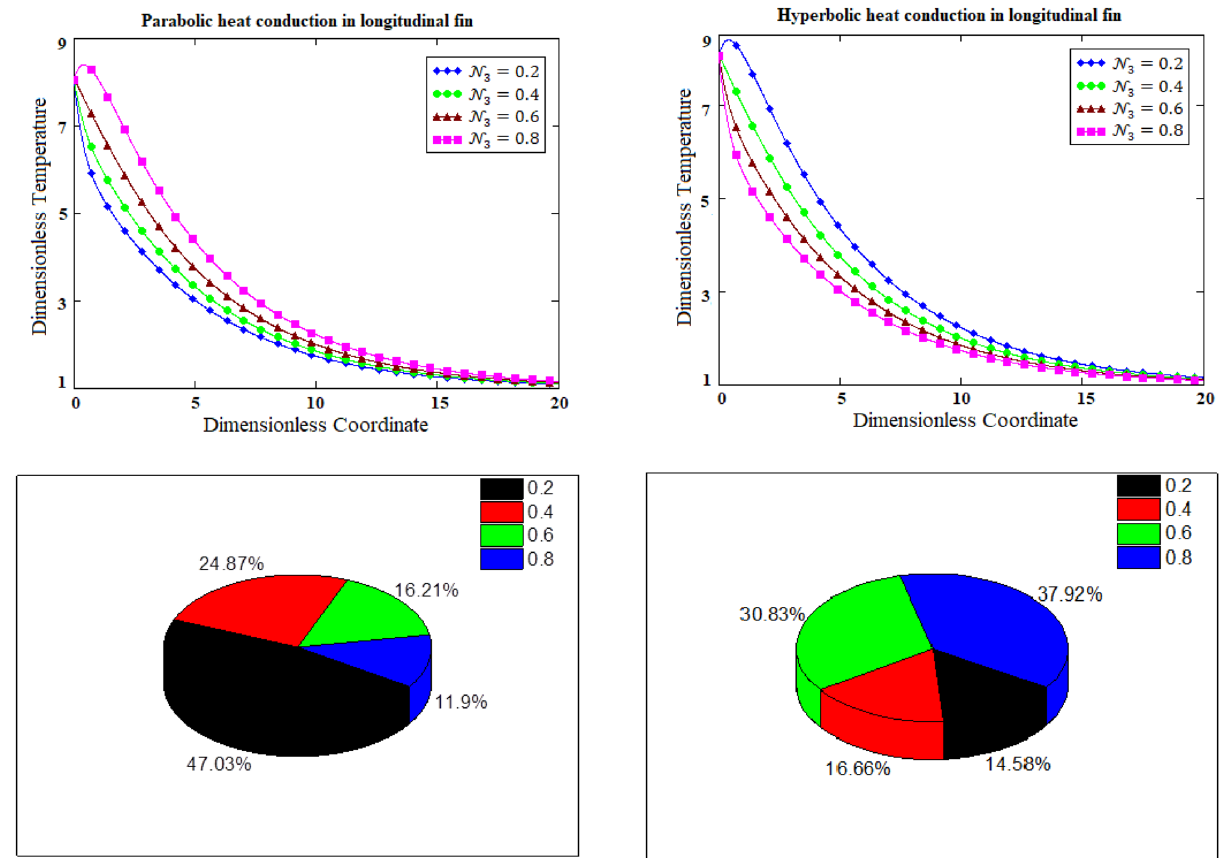
Figure 3. Comparative graphs of parabolic verses hyperbolic heat conduction for the variants of relaxation time based on 2-dimensional and bar chart graphs.